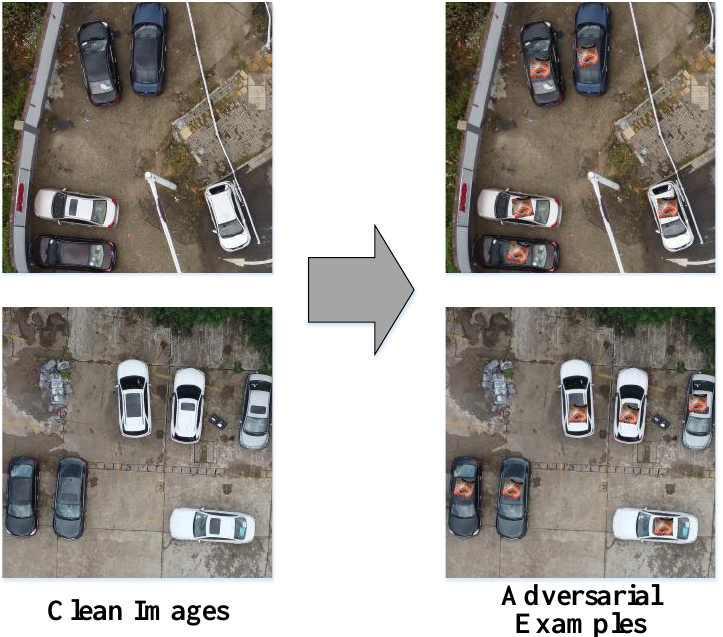
Figure 3. Clean images and adversarial